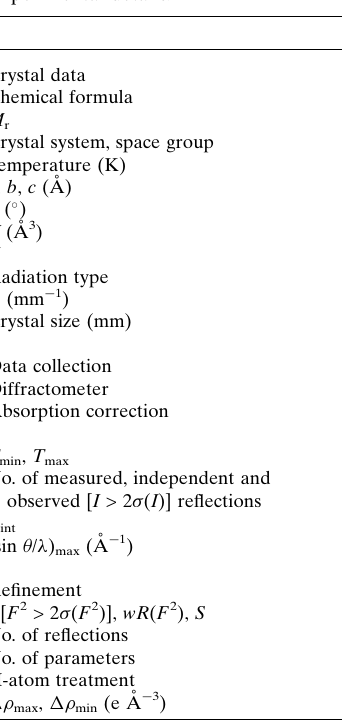
Table 6 Experimental